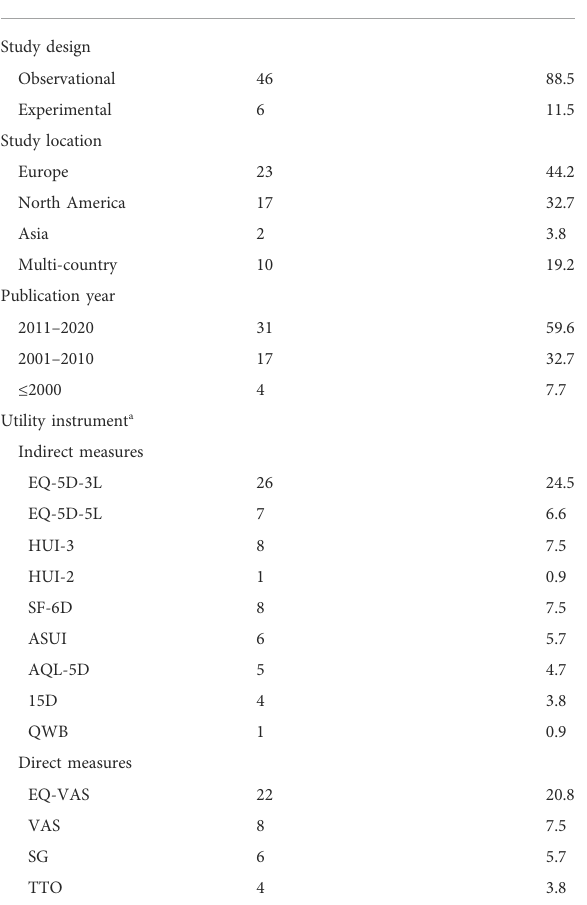
TABLE 1 Study characteristics (N =